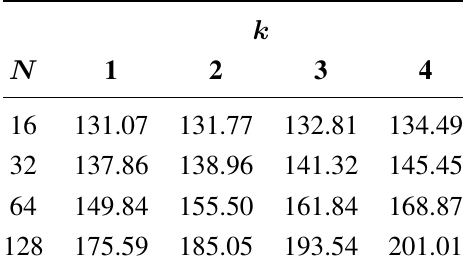
Table 9. Power consumption estimation of the proposed architecture (mW) for various k and N